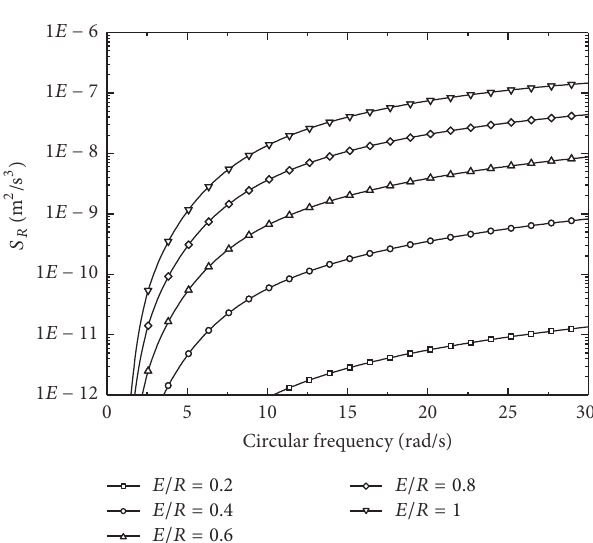
Figure 6: The rocking PSDF